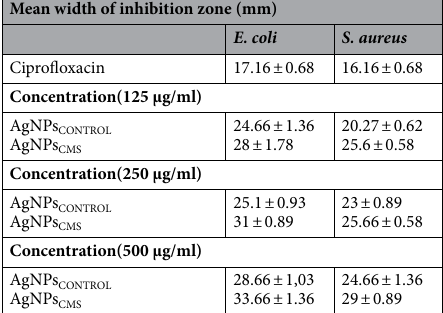
Table 1. Antibacterial activity of biosynthesized silver nanoparticles (AgNPs) at different concentrations (125, 250, and 500 µg/mL) against E. coli and S. aureus . Data represent mean ± SD (n = 3).